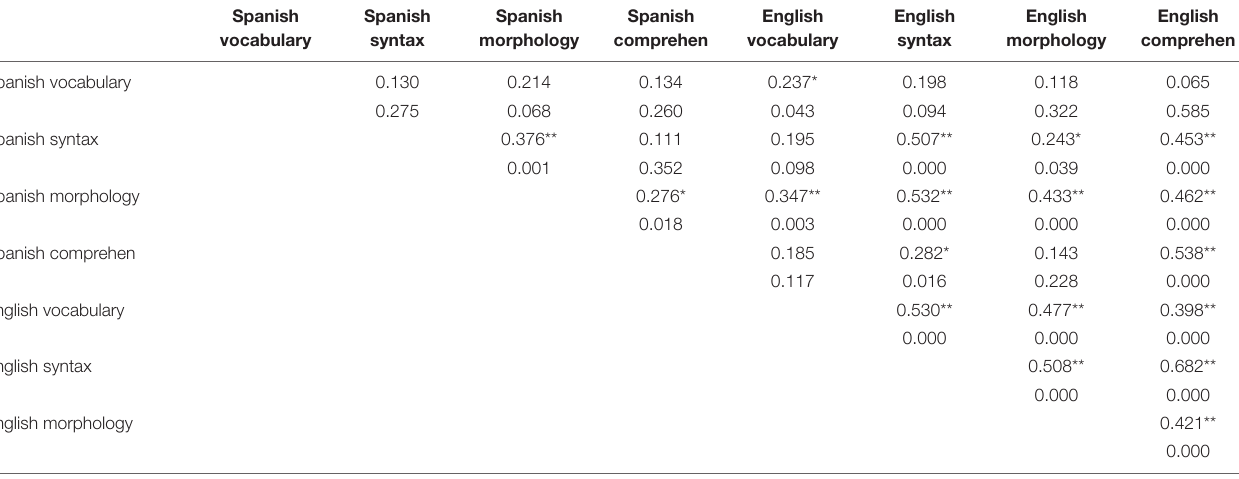
TABLE 2 | Correlation matrix among all the tasks for the whole group.